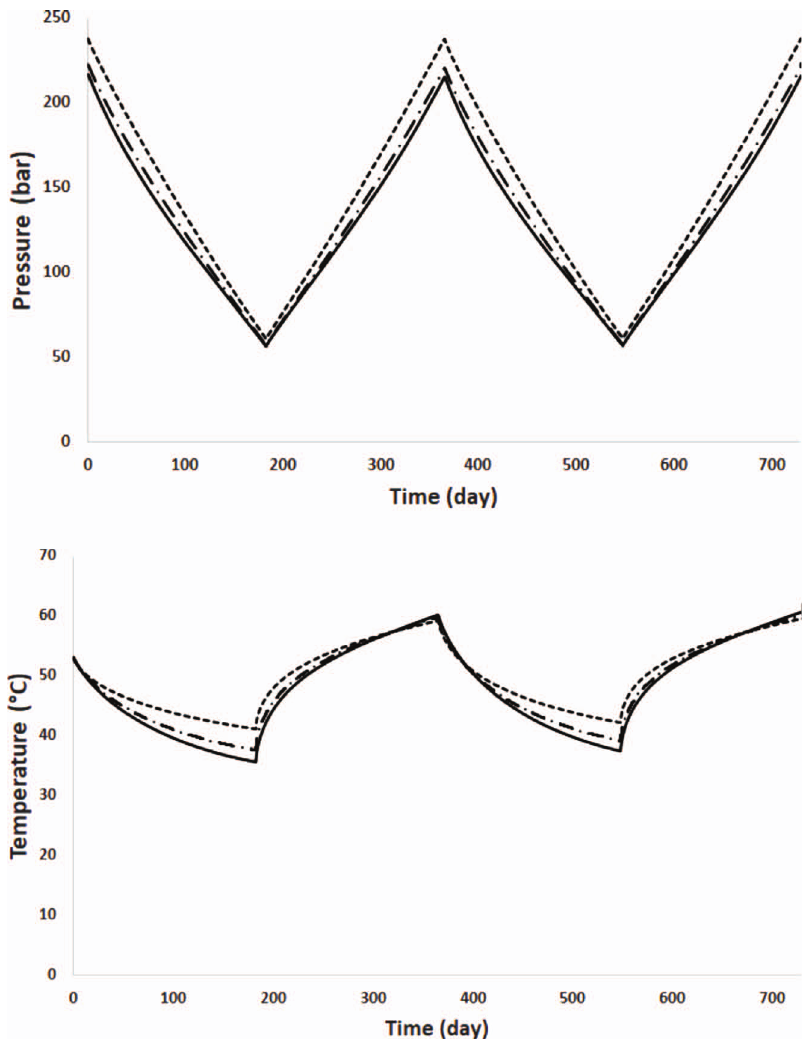
Fig. 9. Top: Variations of well-head pressure for methane (solid line), hydrogen (dotted line) and mix (dash-dotted line). Down: Variations of cavern temperature for methane (solid line), hydrogen (dotted line) and mix (dash-dotted